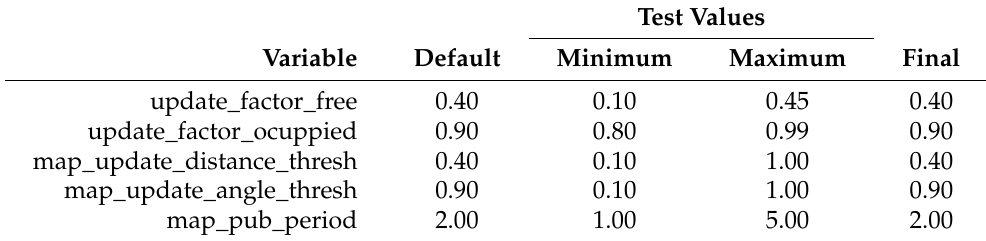
Table 8. Default, tuning and final values for HECTOR-SLAM.